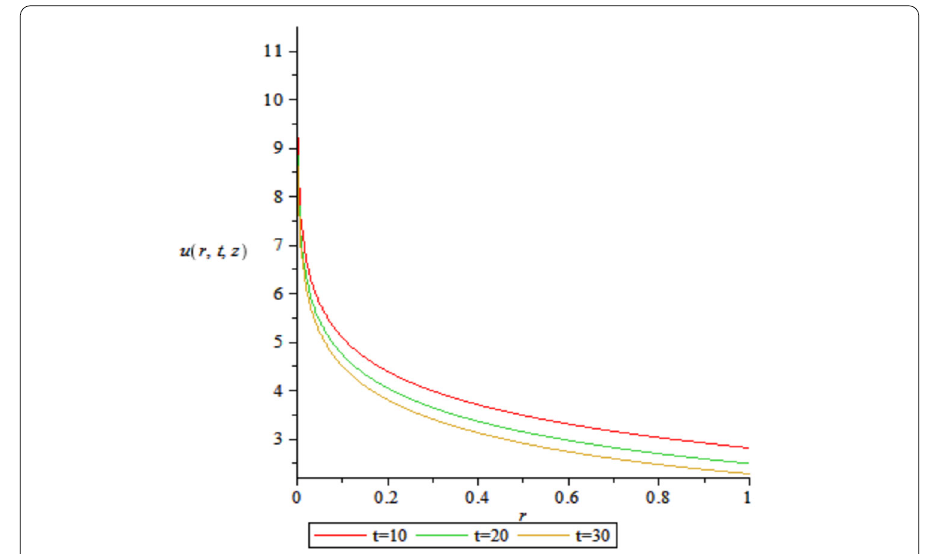
Figure 3 Velocity component u ( r , t , z ) at z = 5, c 2 = 1, and c 4 = –1